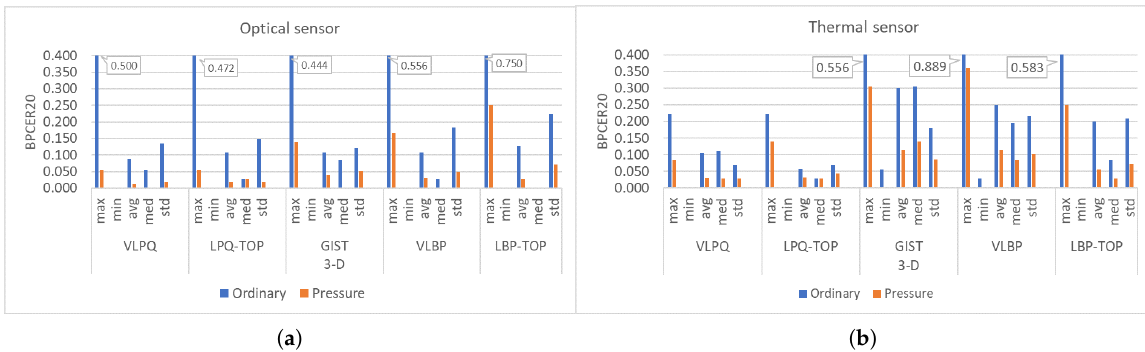
Figure 11. The influence of pressure on the PAD subsystem efficiency (Unshown bars on the min refer to the value